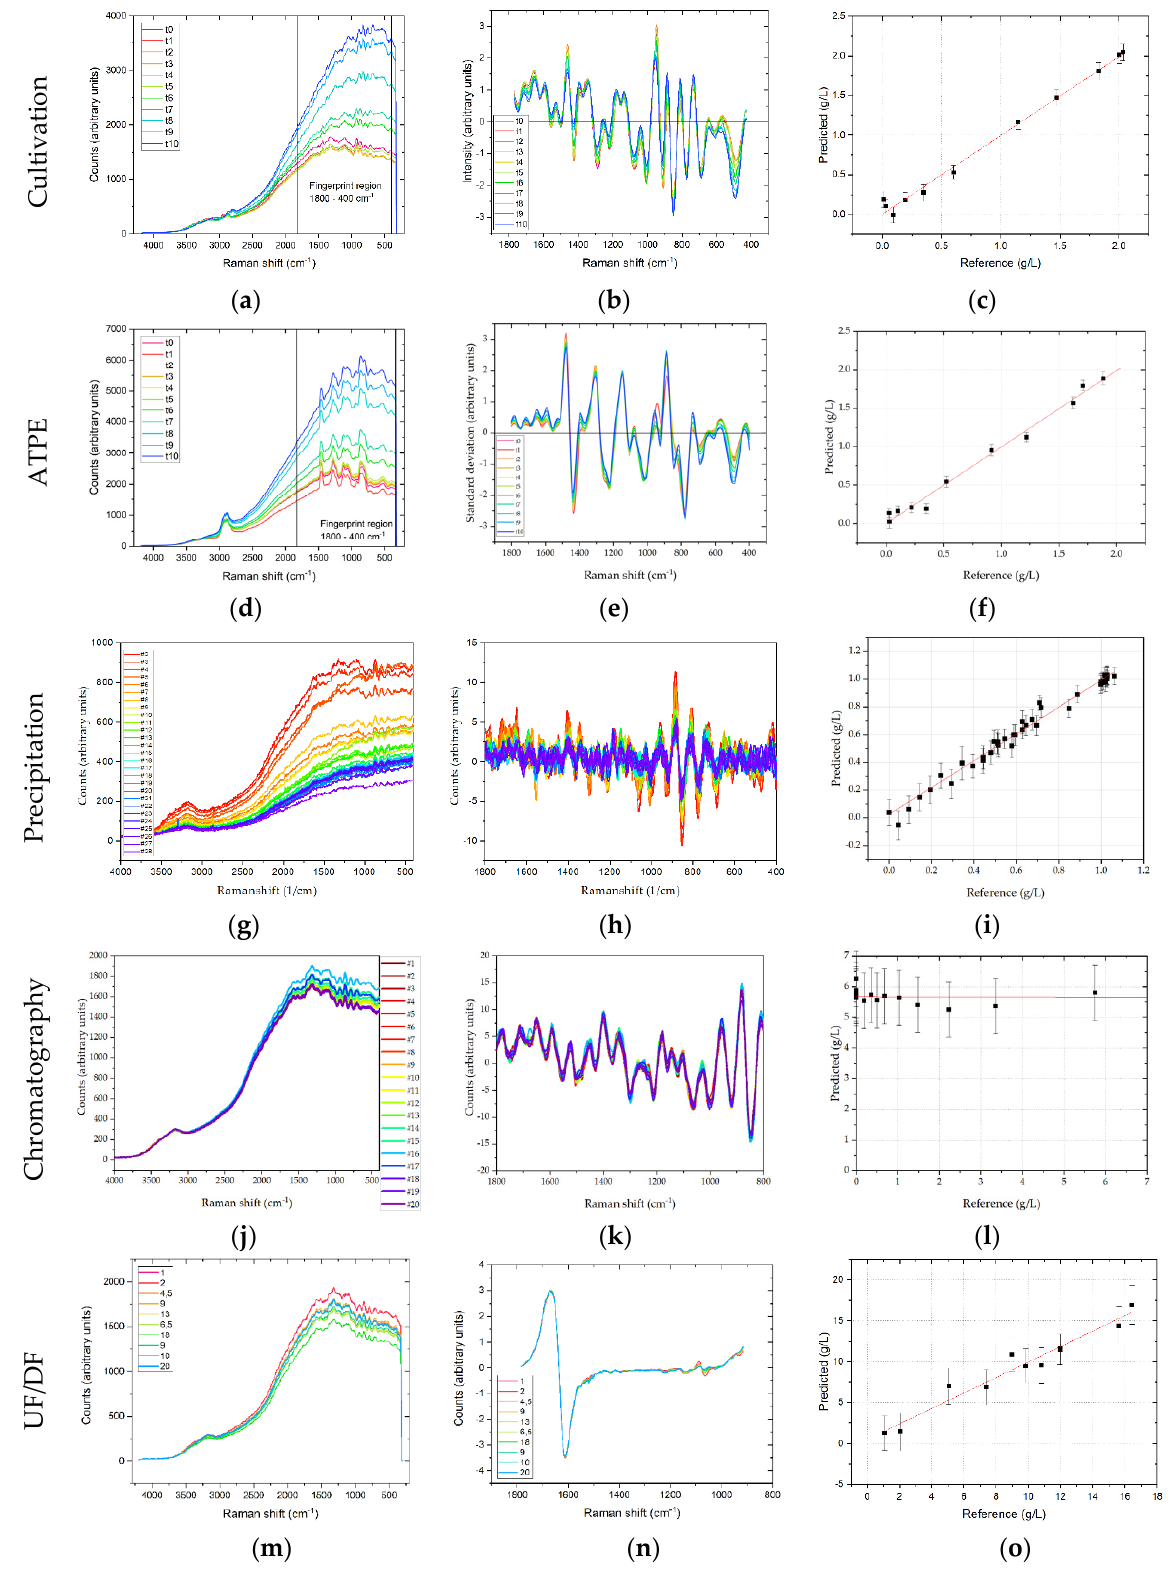
Figure 7. Raman spectra: raw ( a , d , g , j , m ), after preprocessing ( b , e , h , k , n ) and PLSR results ( c , f , i , l , o ). Spectra are color-coded from high concentration (blue) to low concentration (red).